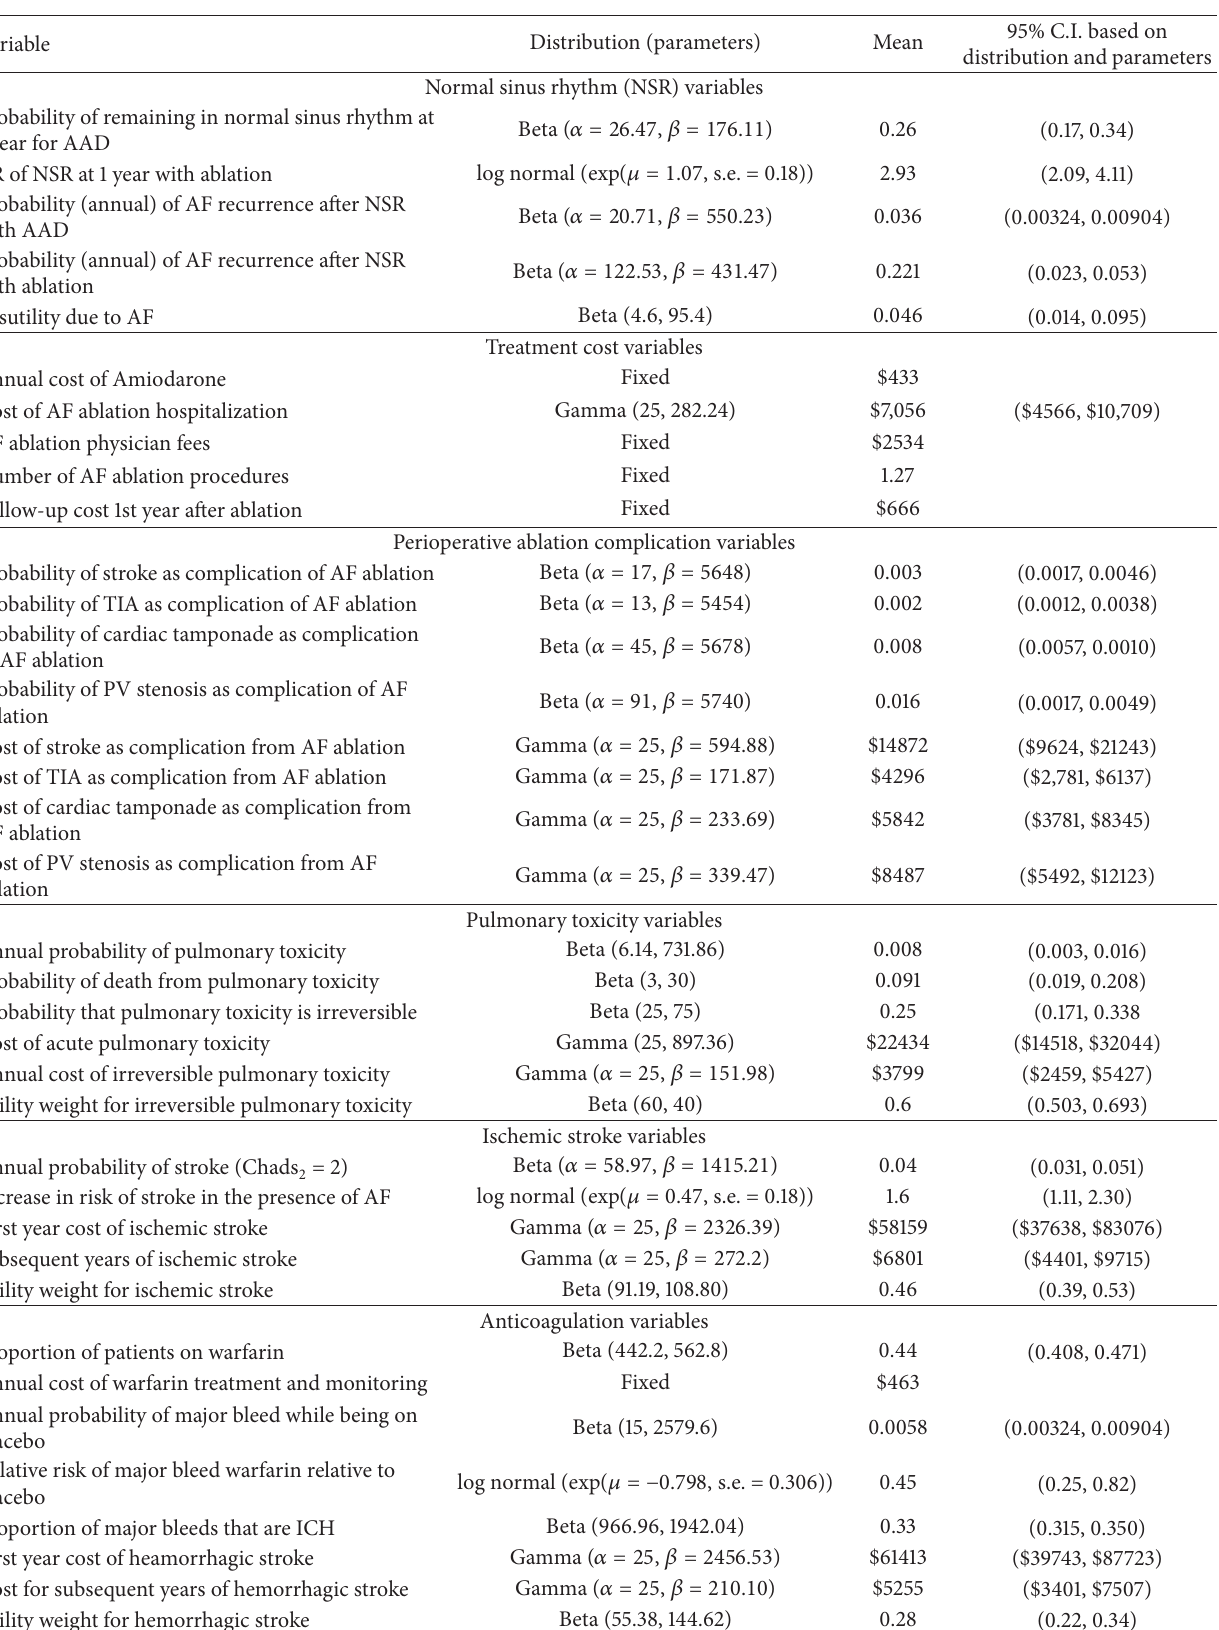
Table 2: Distributions used for model parameters in probabilistic sensitivity